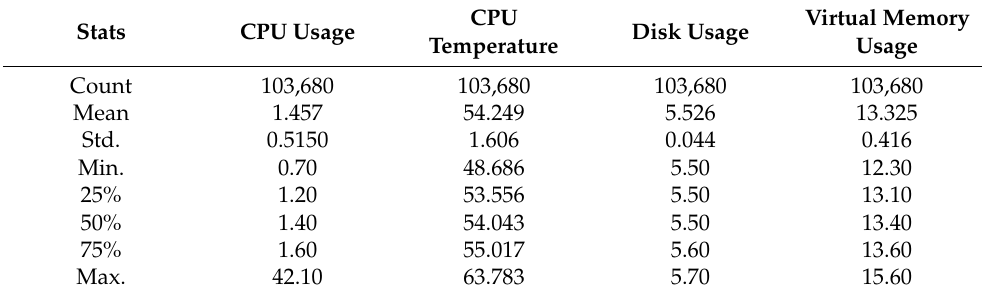
Table 9. Dataset statistics.